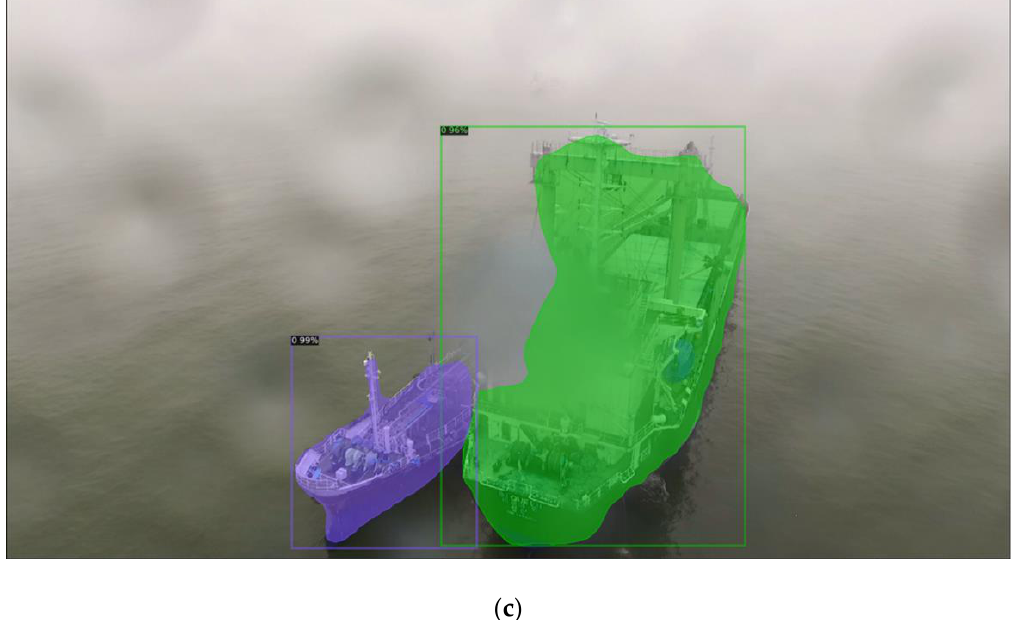
Figure 7. Comparison of the Bounding Model Test Results for the Mask R-CNN Model. ( a ) Bounding Box Result of R50-C4 3x; ( b ) Bounding Box Result of R50-DC5 3x; ( c ) Bounding Box Result of R50-FPN 3x.